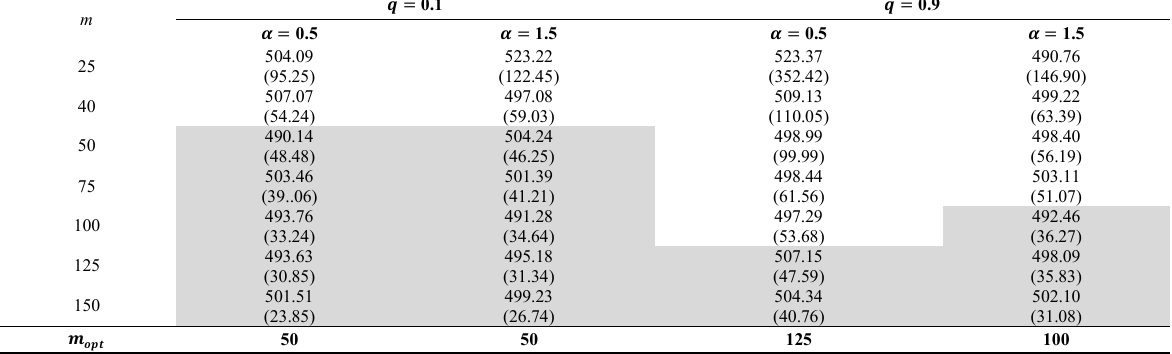
The 𝐶𝐴𝐴𝑅𝐿 and 𝐶𝑆𝐷𝐴𝑅𝐿 values of W-GWMA( 𝑞 , 𝛼 ) monitoring scheme (cid:2868) (cid:2868) 𝒒 = 0.1 𝒒 = m